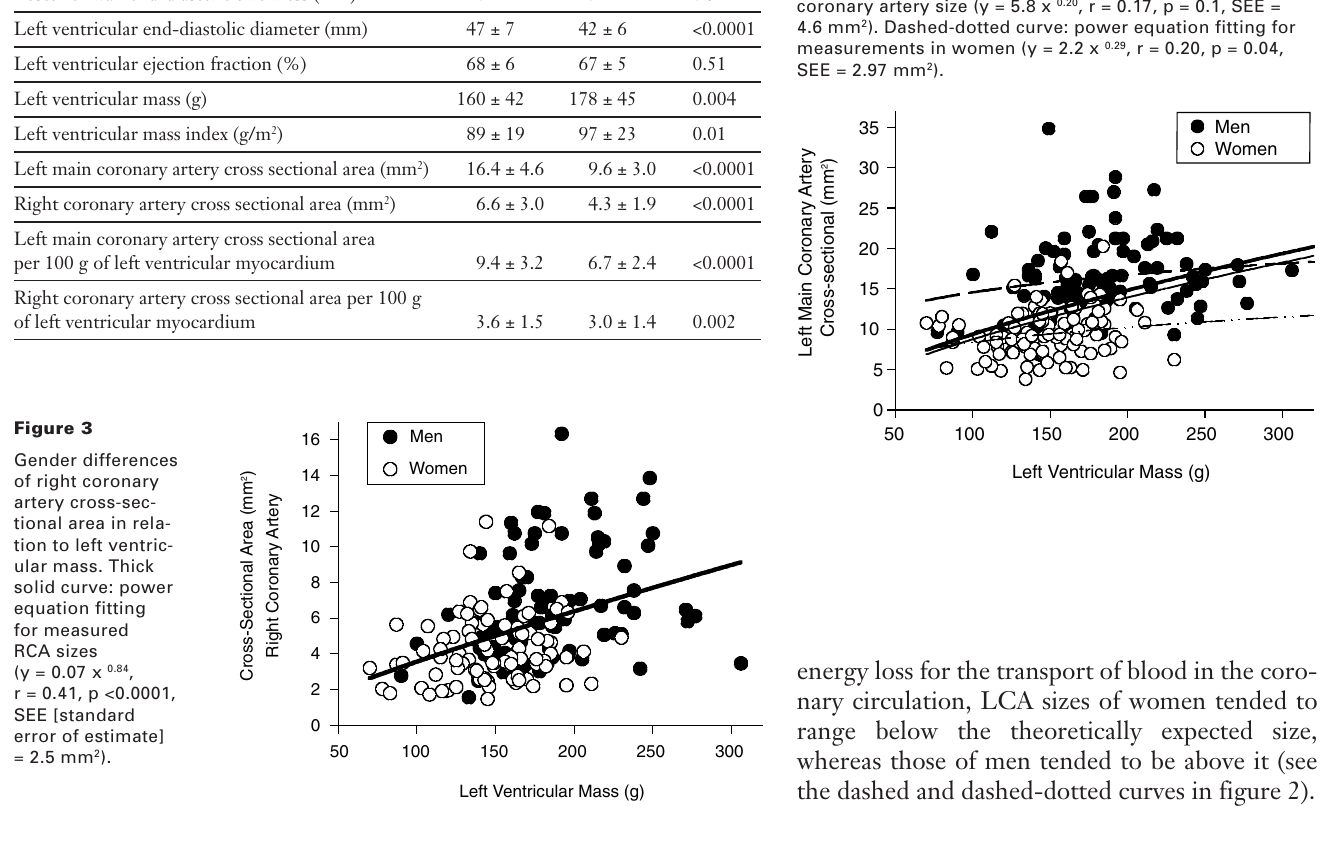
compare measurements in men with theoretically expected coronary artery size (y = 5.8 x 0.20 , r = 0.17, p = 0.1, SEE =